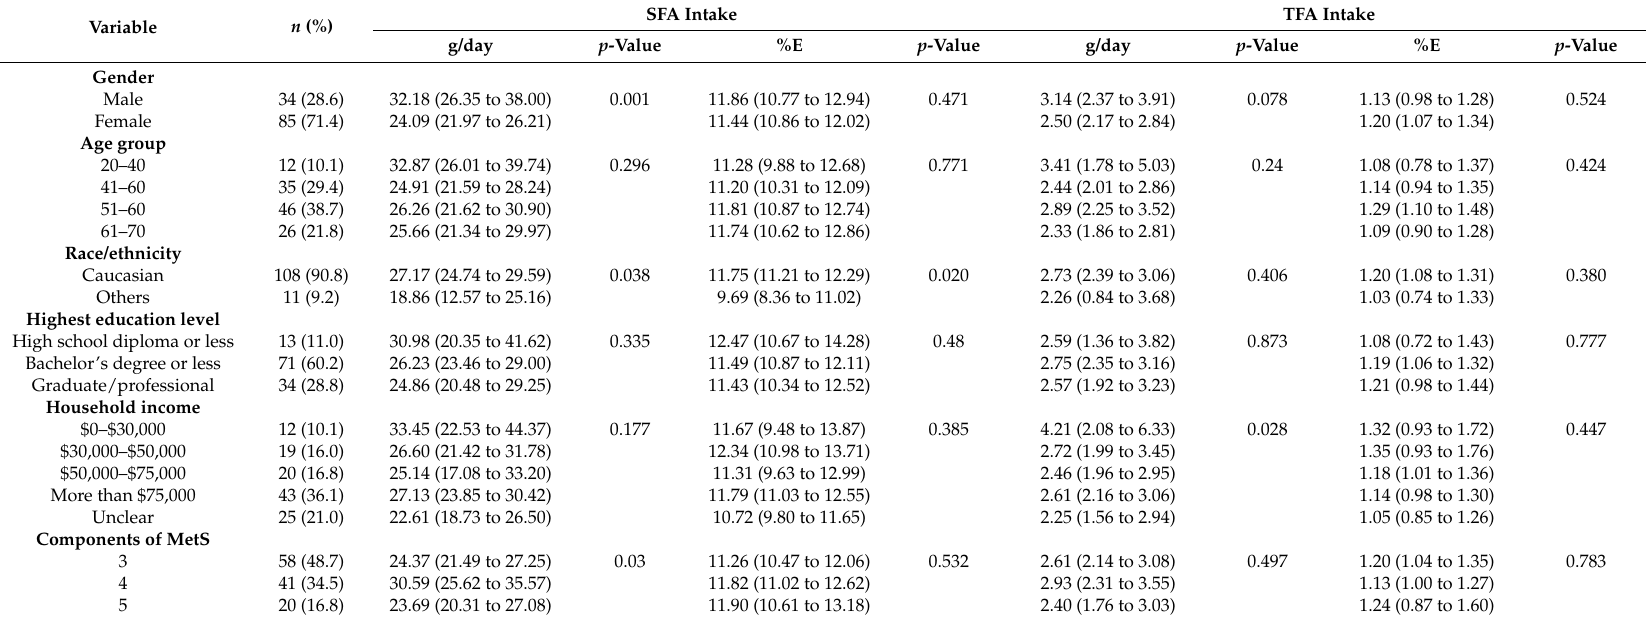
Table 2. Daily Saturated Fatty Acids (SFA) and Trans Fatty Acids (TFA) intake at baseline by participants’ demographic